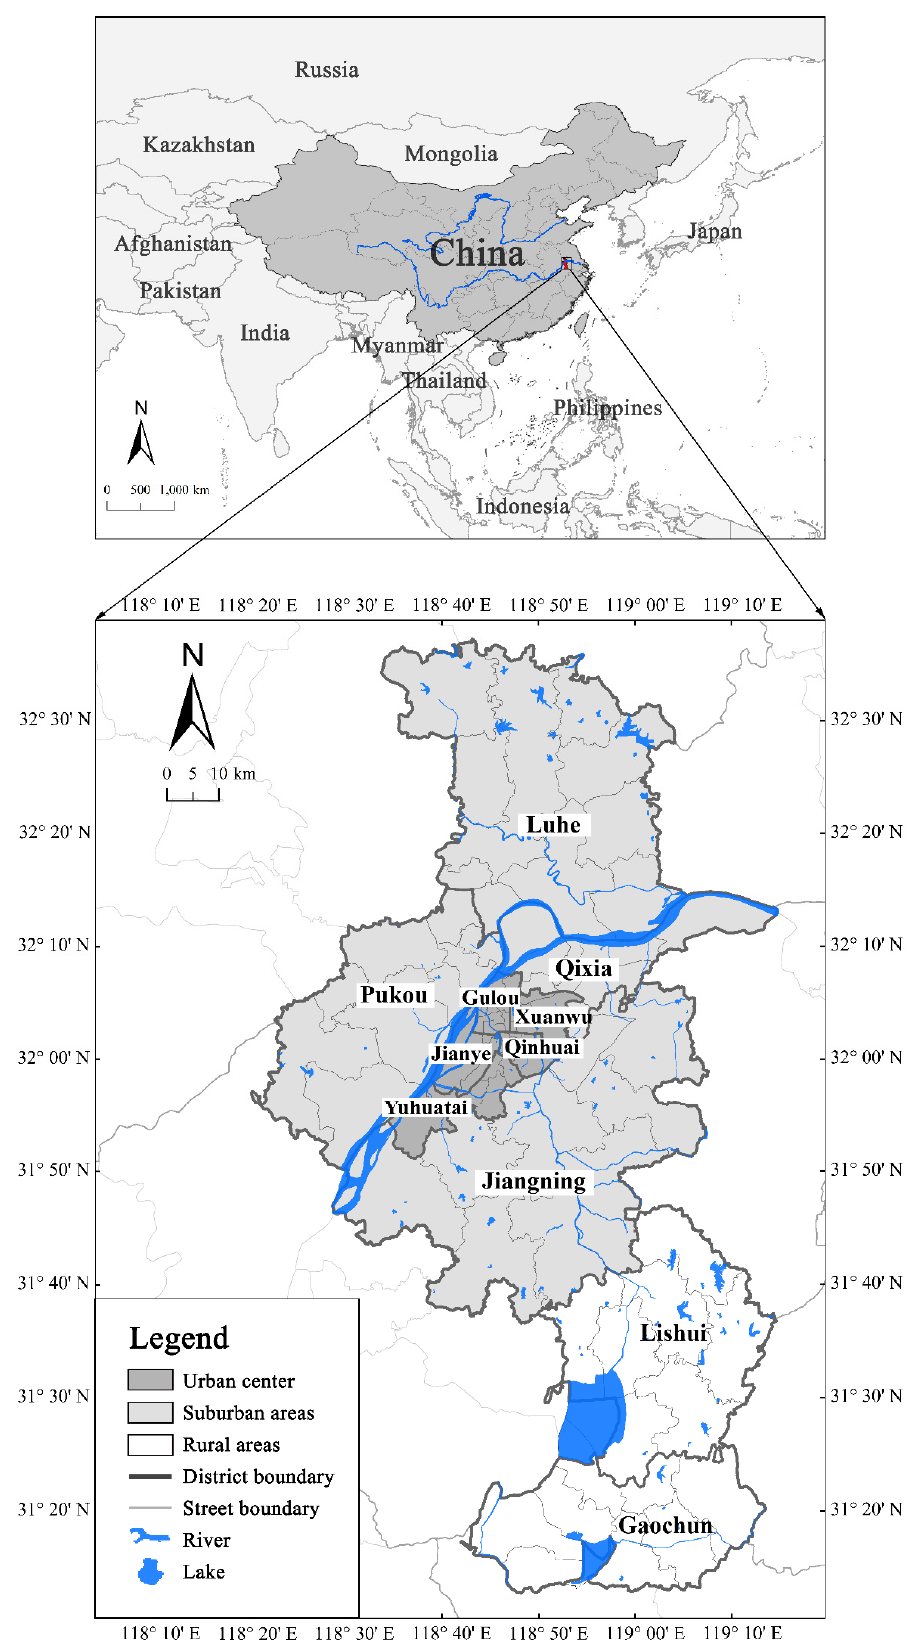
Figure 1. Location of Nanjing, China.